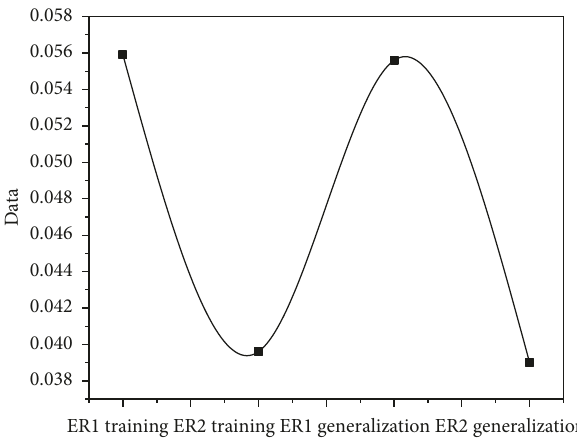
Figure 4: FWA3 model simulation results.